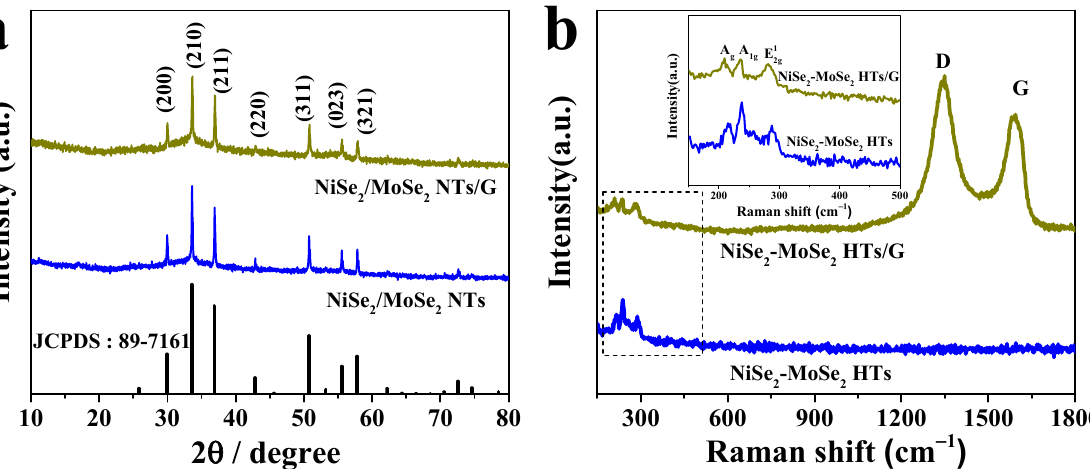
Figure 1. ( a ) XRD patterns of NiSe 2 -MoSe 2 HTs and NiSe 2 -MoSe 2 HTs/G composite. ( b ) Raman spec- tra of NiSe 2 -MoSe 2 HTs and NiSe 2 -MoSe 2 HTs/G composite. The inset is the enlarged Raman spec- tra.